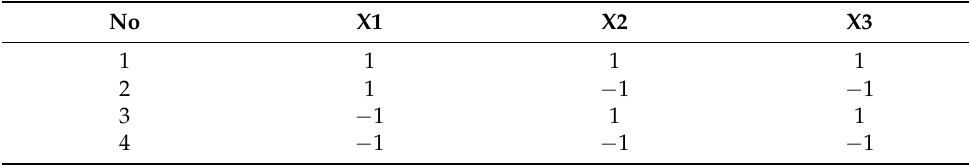
Table 2. Two-level orthogonal design of the experiment for three